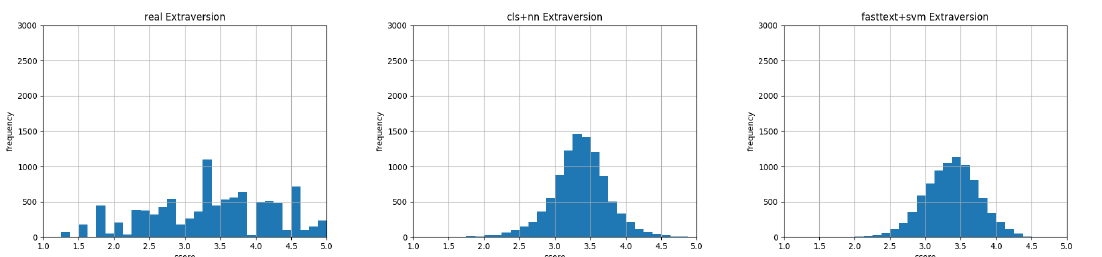
Figure 8. Extraversion: Histograms representing data distribution of gold standard on the left, our model result in the middle, and previous state of the art by Carducci et al. [8] on the right.